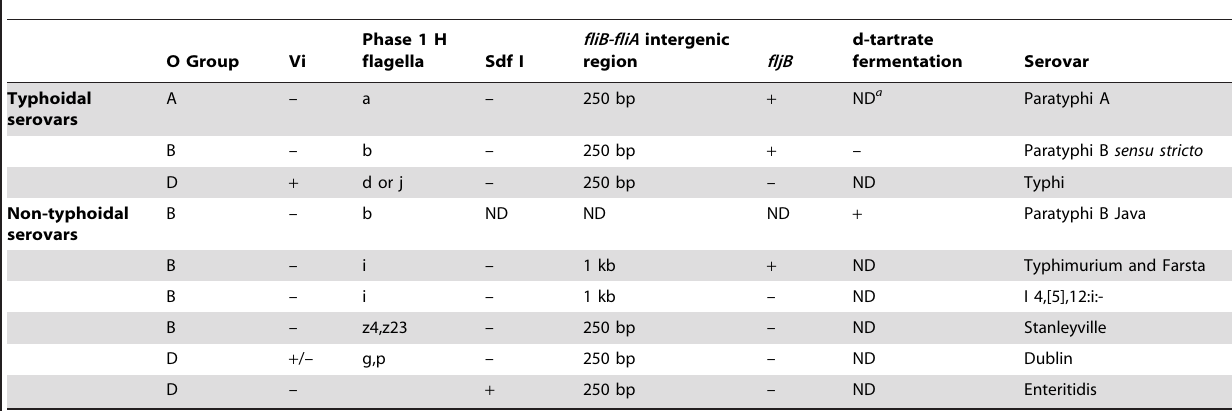
Table 5. Salmonella serovars identified by the PCRs described in this report and in Levy et al. [18].